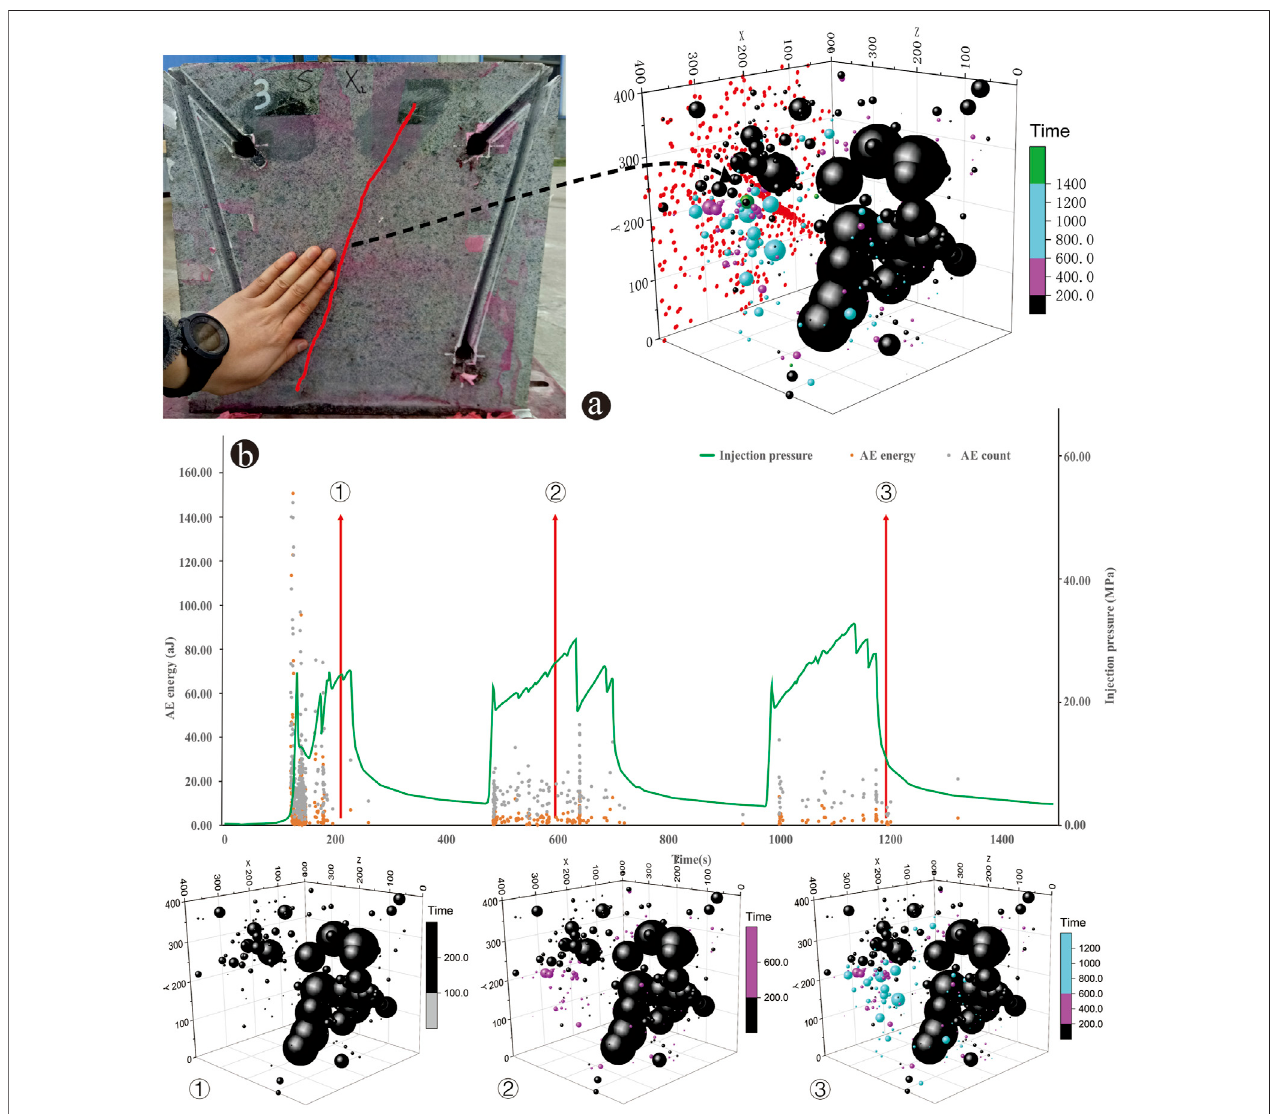
FIGURE 7 | AE spatial distribution characteristics of HDR400-1 (A) AE spatial distribution compared with the surface appearance of the sample. Each sphere representsasingleAEevent,andthesizeofthespheresrepresentthevalueofAEenergy.TheredscatterpointsaretheprojectionoftheAEeventsontheX-Yplane; (B) AE spatial distribution of each pump periods, and ① – ③ represent the fi rst to third pump periods.